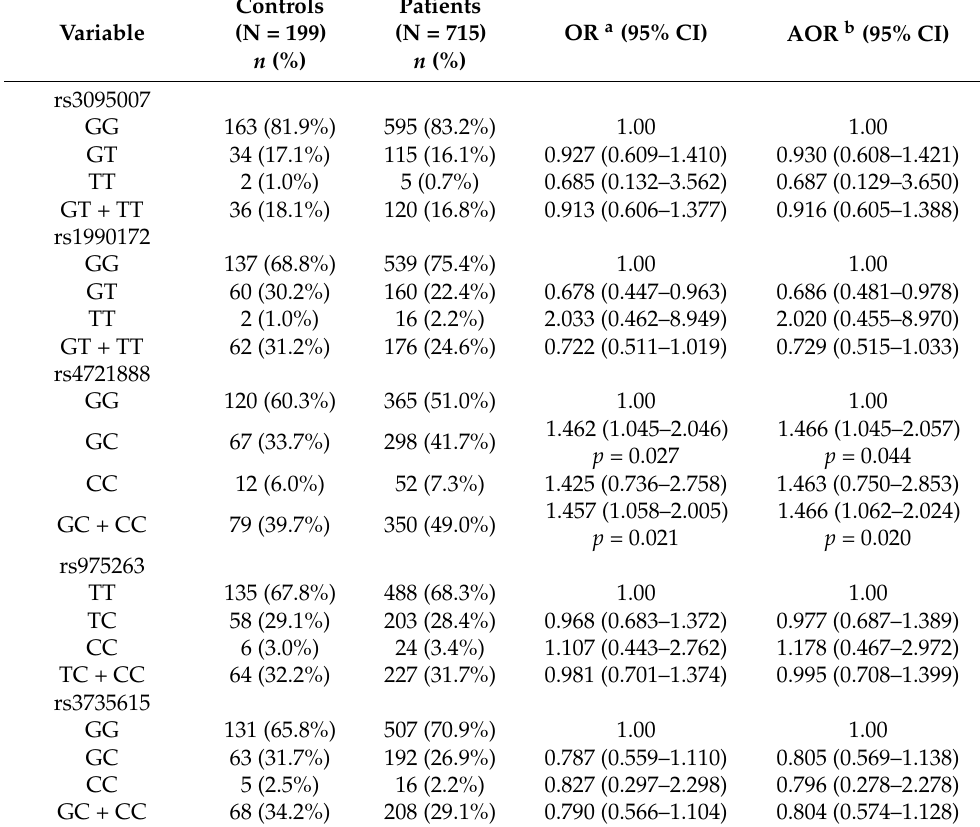
Table 3. The MACC1 SNPs genotype frequencies of people who were used to chewing betel quid.